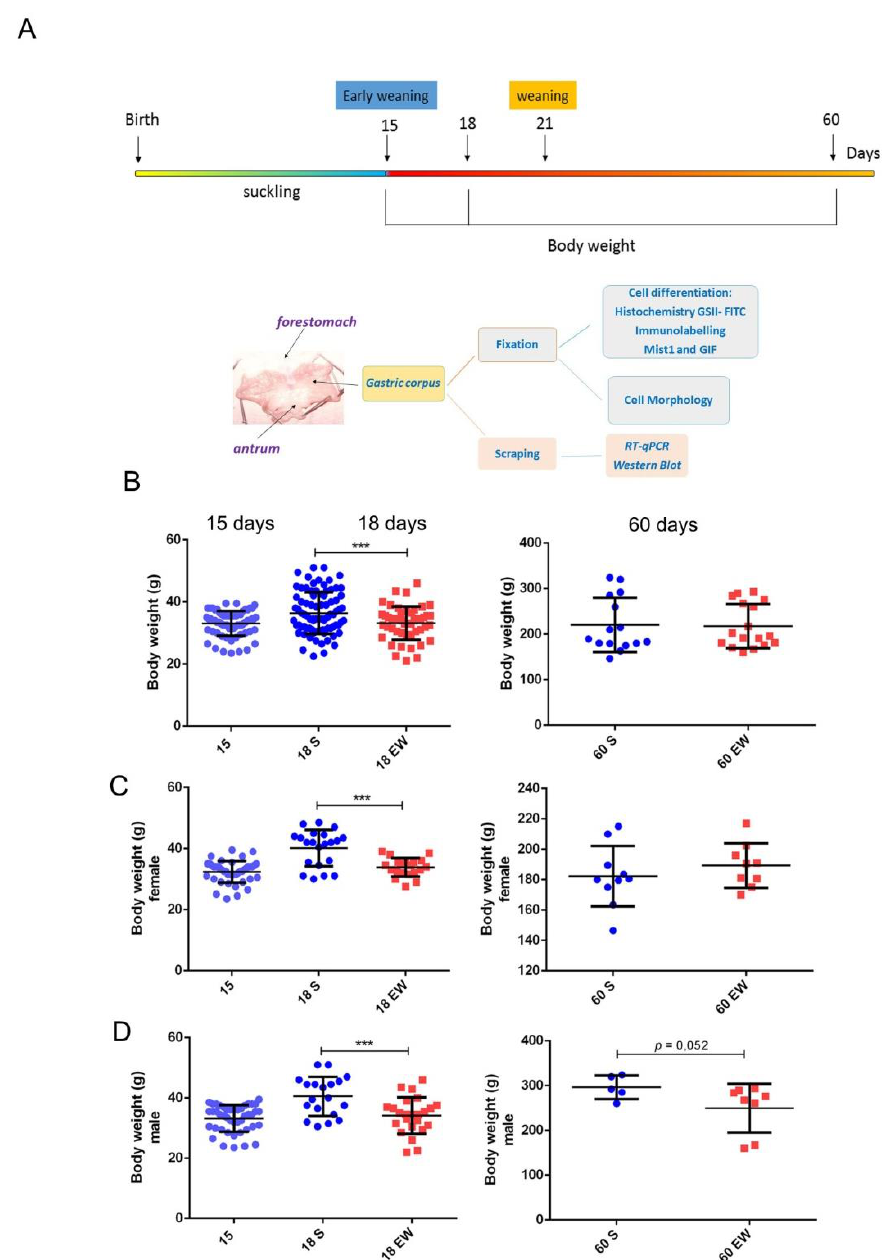
Figure 1. Immediate and late effects of early weaning on body weight gain. ( A ) Experimental design for gastric samples collection and body weight control for comparison of suckling (S) and early weaning (EW) groups at 15, 18, and 60 days. ( B ) Body weight (g) was reduced immediately after early weaning (18 days), and differences decreased (60 days) when all rats were studied. ( C , D ) Data was analyzed for females and males, separately. The body weight of each rat in S (blue) or EW (red) condition is represented individually. Means ± SD is also indicated for each group. Results were compared after unpaired Student t test between S and EW at one age as *** p < 0.0001.